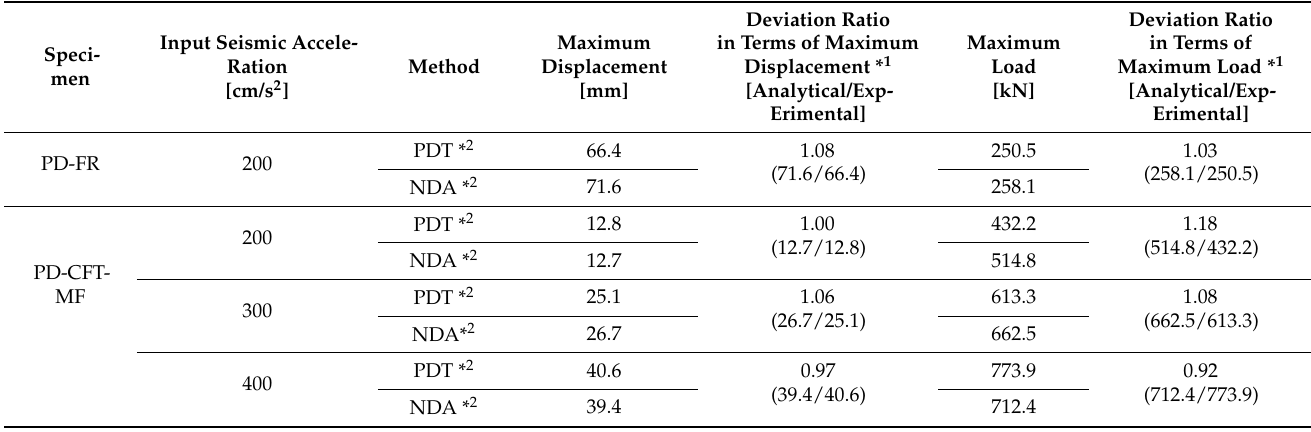
Table 7. Comparison of maximum response load-displacement relationship between non-linear dynamic analysis and pseudo-dynamic test results.